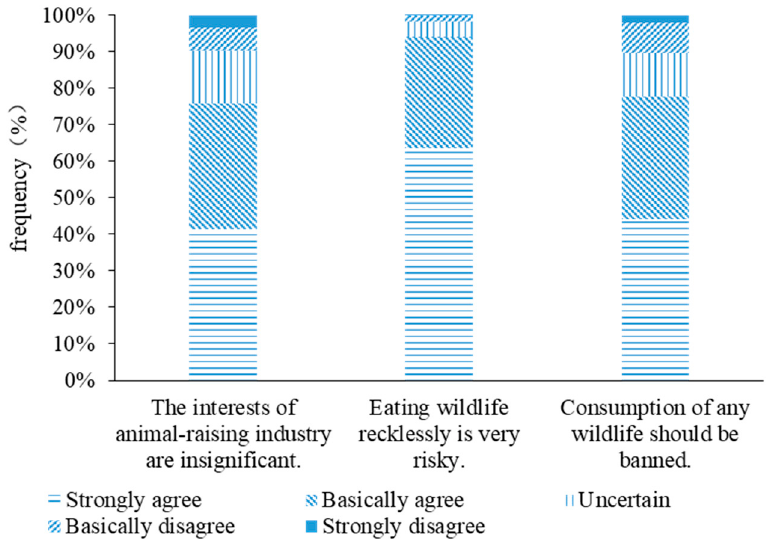
Figure 3. Public agreement to information related to COVID-19.